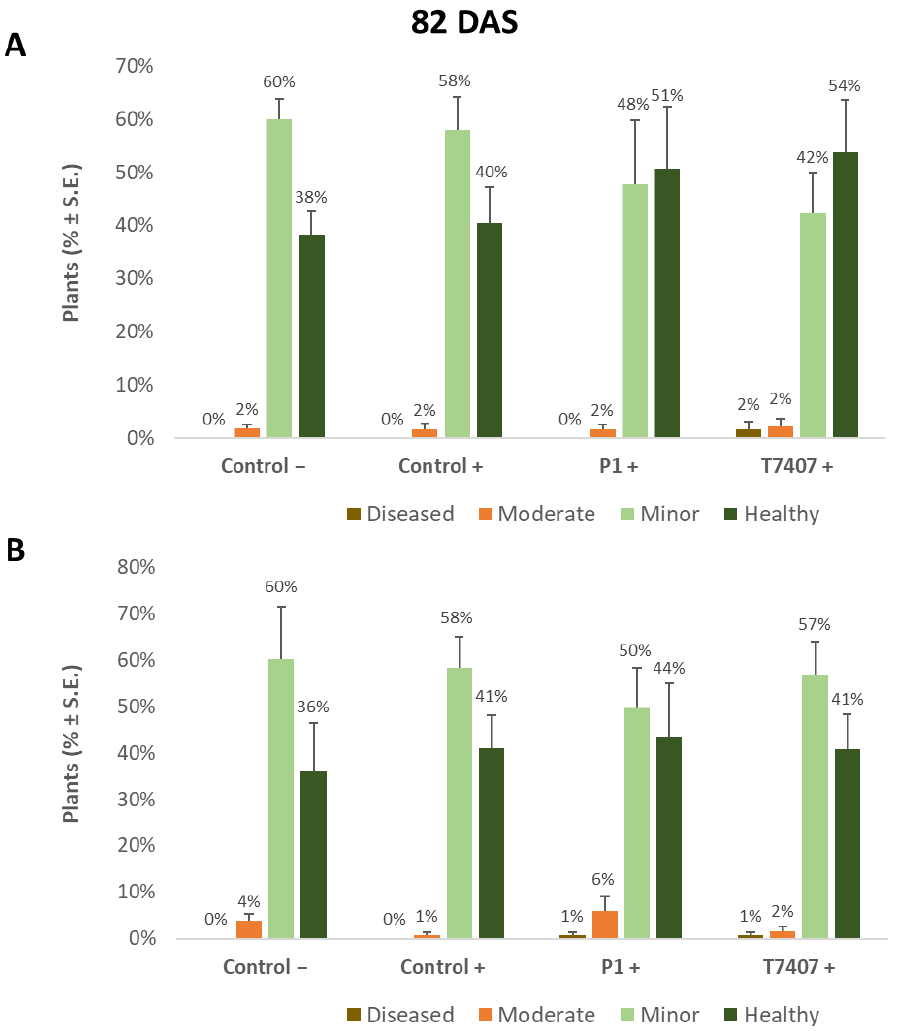
Figure 6. Quantitative estimation of cobs’ spathes symptoms at the end of the 2020 field experiment (82 DAS, 33 DAF). ( A ). Stabbing-free treatments. ( B ). Stabbing inoculation treatments. Categories are described in Figure 5. The experiment’s treatments and controls are depicted in Figure 3. Values are calculated based on 118–241 plants in each treatment in at least four repeats. Deviation bars represent standard error. No statistical difference between the treatments or between the treatments and the controls could be identified using the one-way analysis of variance (ANOVA)